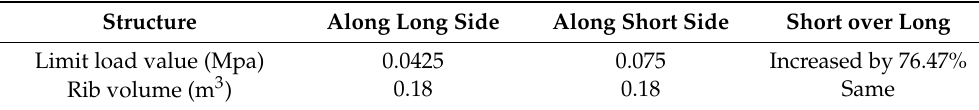
Figure 1. Contours of von Mises stress distribution on a thin plate under limit load. Table 1. Comparison of reinforcement effects for the ribs on a